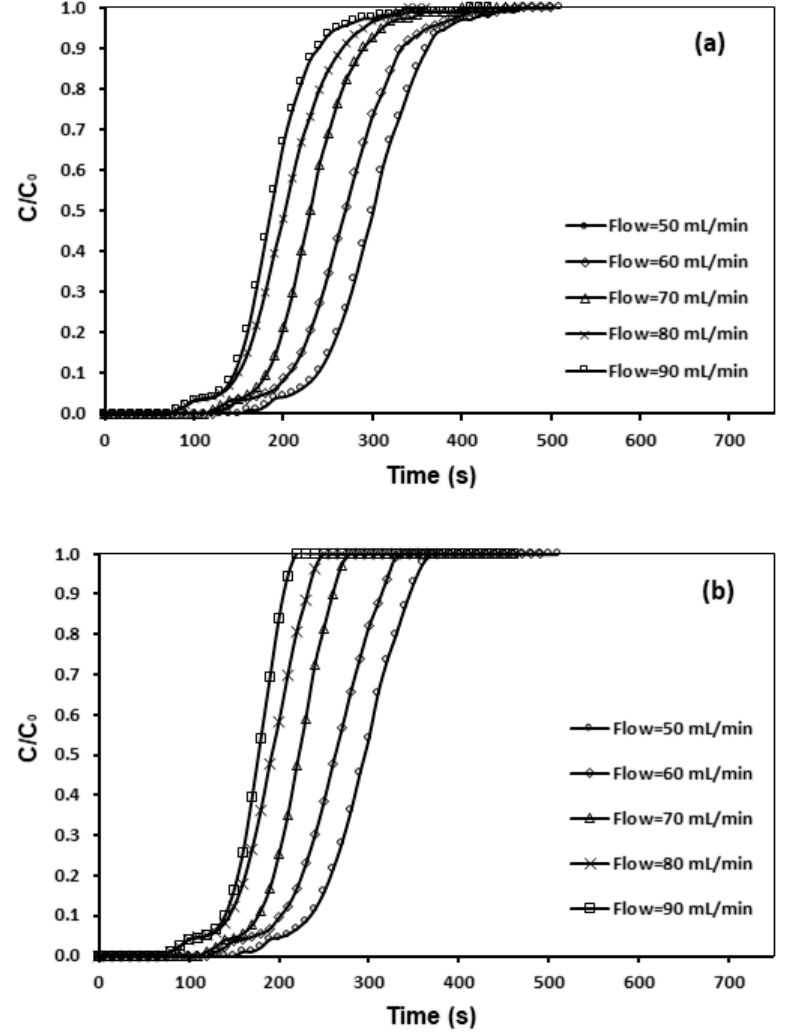
Figure 11. Breakthrough curve and effect of flow rate of ( a ) CNFCM and ( b ) modified CNFCM in constant T = 30 ° C, P = 1 bar and 10% CO 2.